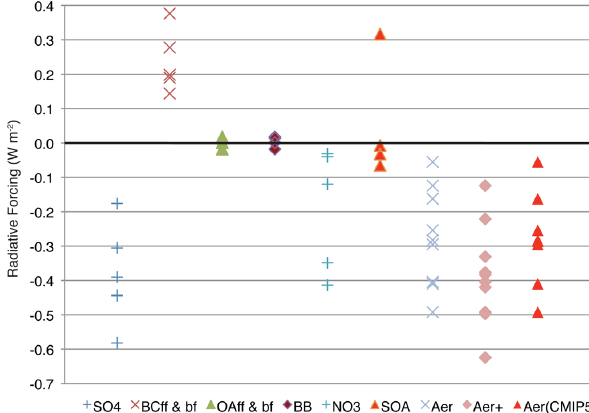
Fig. 8. Global mean aerosol RF (direct) by component and total. Individual points are from different models. Aer are totals. Aer + are totals including adjustment by adding in forcing due to miss- ing nitrate and SOA (see text). Aer(CMIP5) is the subset of AC- CMIP models that also participated in CMIP5. The number of mod- els for each component is: sulfate 9, BCff + bf 5, OAff + bf 4, BB 4, nitrate 5, SOA 4, Aer 10, Aer + 10, and Aer(CMIP5) 8. Note that HadGEM2 nitrate (Bellouin et al., 2011) and NCAR-CAM3.5 nitrate are included in those models’ Aer + but not the Aer or Aer(CMIP) values. MIROC-CHEM nitrate and SOA are included in their Aer and Aer + values, but not in their Aer(CMIP)